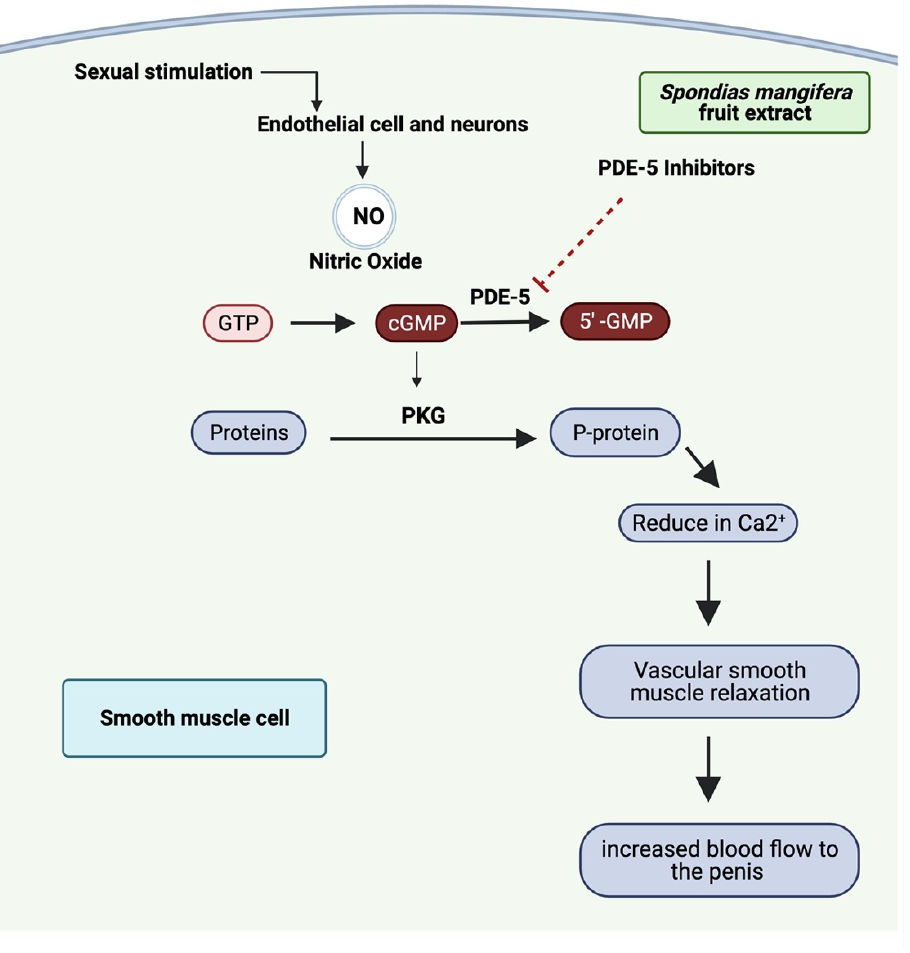
Figure 13. The possible mechanism of smooth muscle relaxation through PDE5 inhibition.